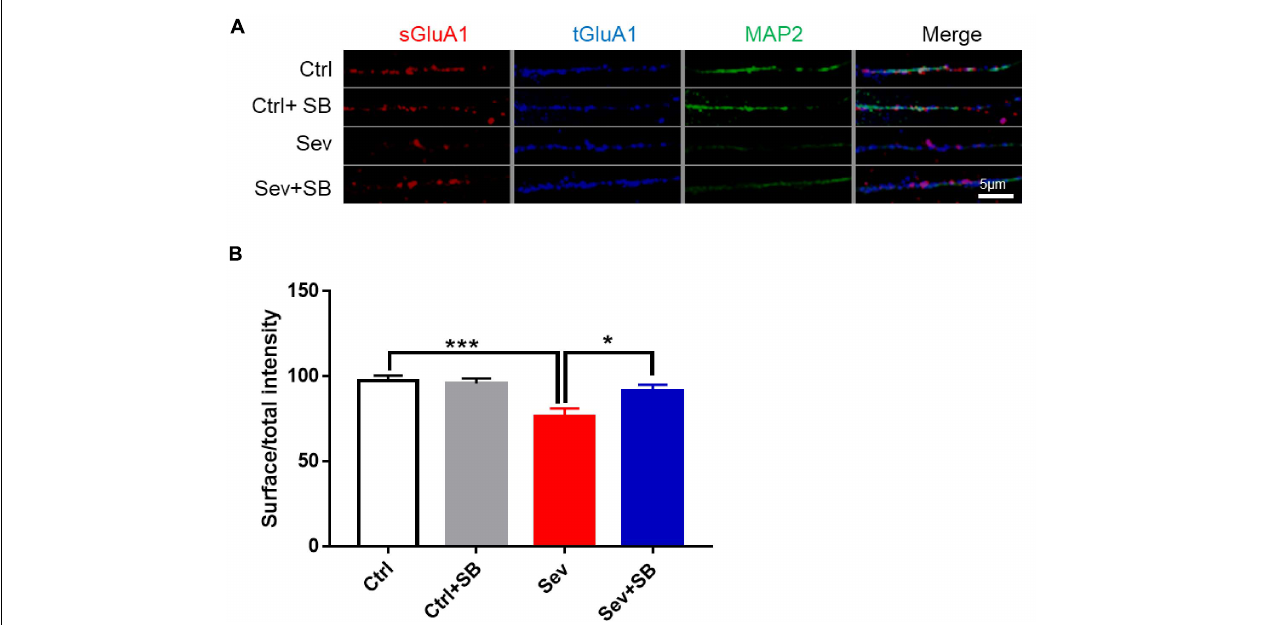
FIGURE 5 | SB 366791 attenuated sevoflurane-induced reduction of surface GluA1 in hippocampus neurons. (A) Fluorescent images of surface GluA1 (sGluA1) and total GluA1 (tGluA1) staining in hippocampus neurons from Ctrl and Sev cultures treated with TRPV1 antagonist SB 366791 (10 µ M). (B) Quantitative analysis of (A) [3 cultures per group, one-way ANOVA, F ( 3 , 40 ) = 7.0, p = 0.0007]. Data are presented as the mean ± SEM. ANOVA followed by Bonferroni post hoc test. * p < 0.05; *** p < 0.001. Ctrl, control; Sev, sevoflurane; SB, SB